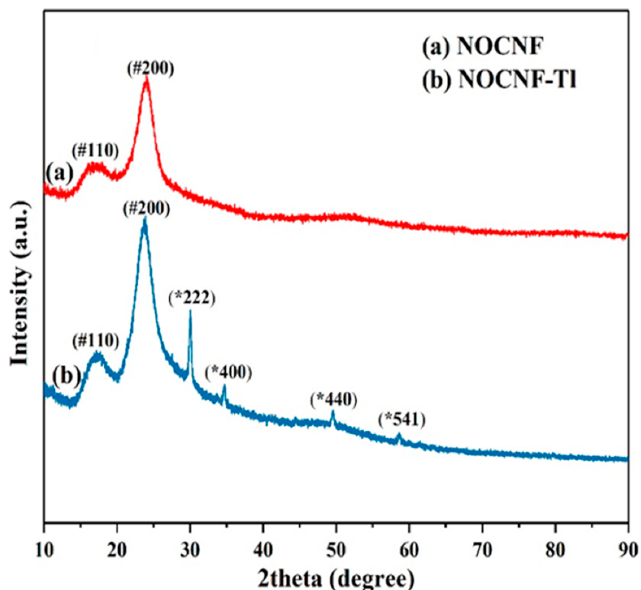
Figure 4. WAXD spectra of ( a ) NOCNF (0.32 wt%), and ( b ) NOCNF-Tl floc (mixed by 0.32 wt% NOCNF and 300 ppm Tl(I)); # represents the diffraction peaks from the cellulose I structure, * represents the diffraction peaks from the Tl 2 O 3 crystal structure.